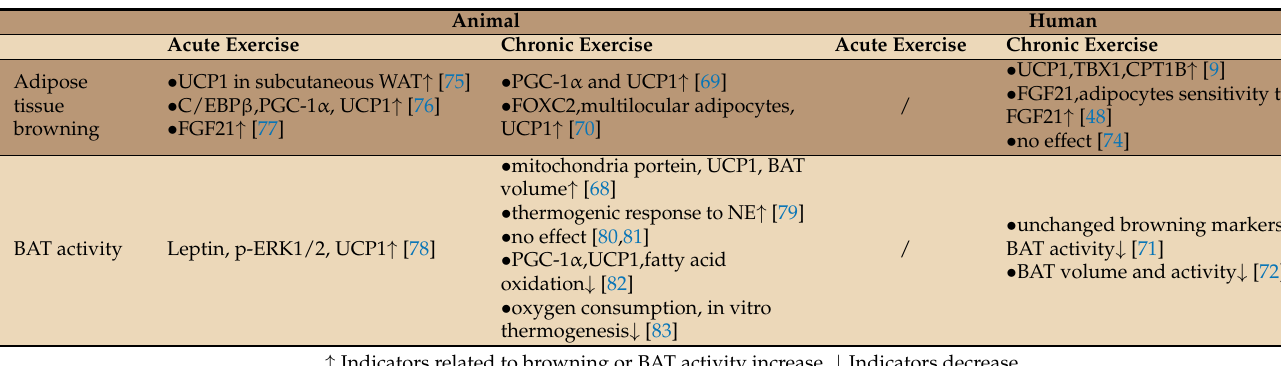
Table 1. The effects of acute and chronic exercise interventions on adipose tissue thermogenesis and browning in humans and animals.